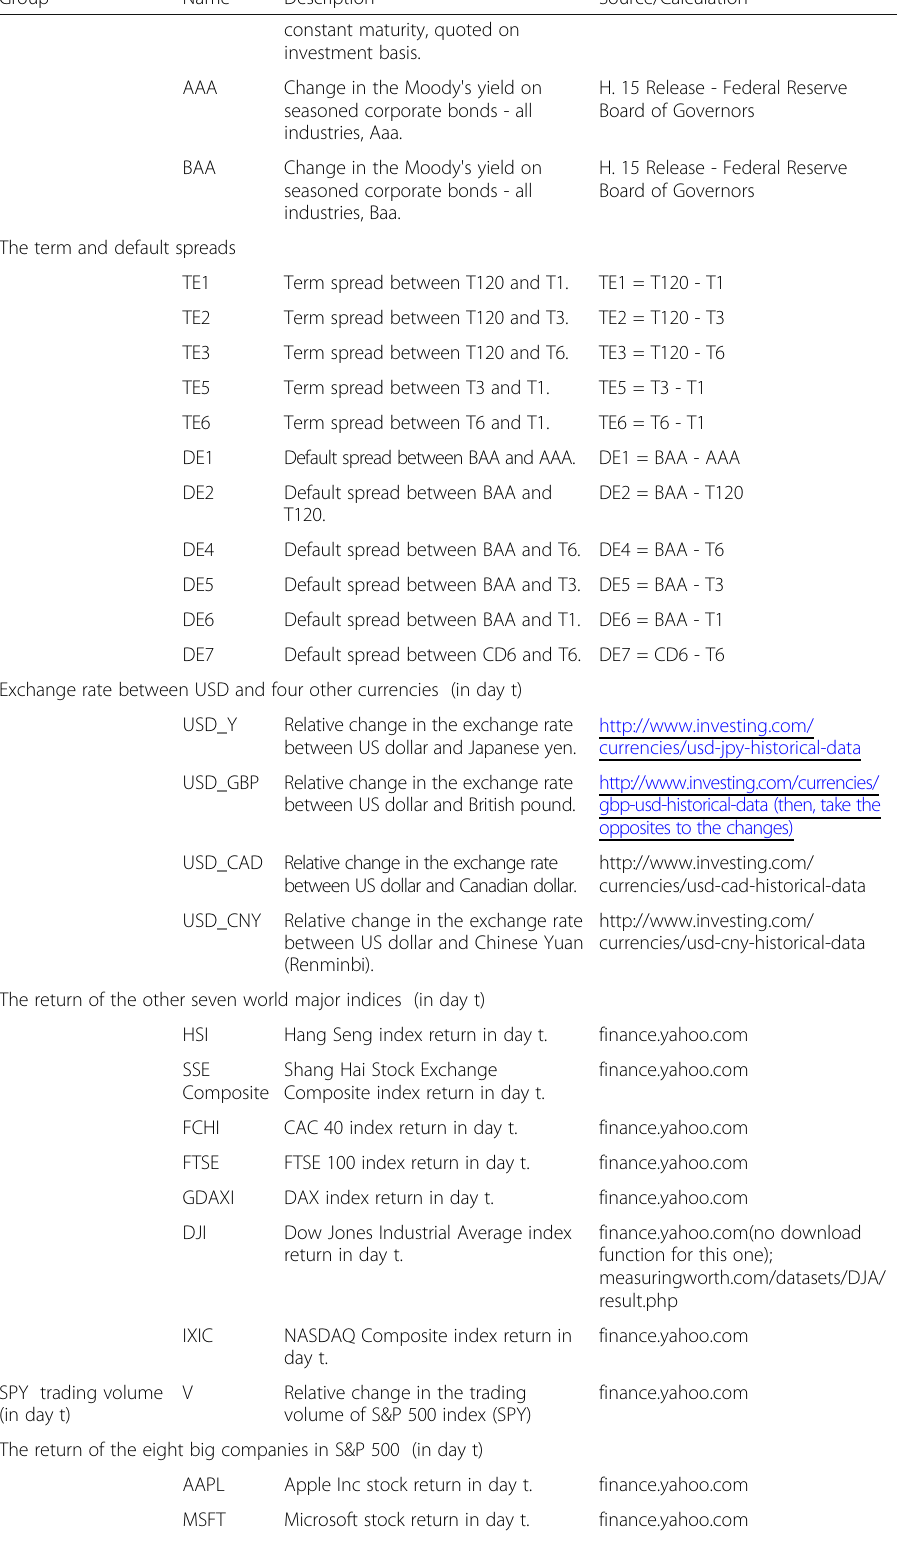
Table 10 The 60 financial and economical features of the raw data